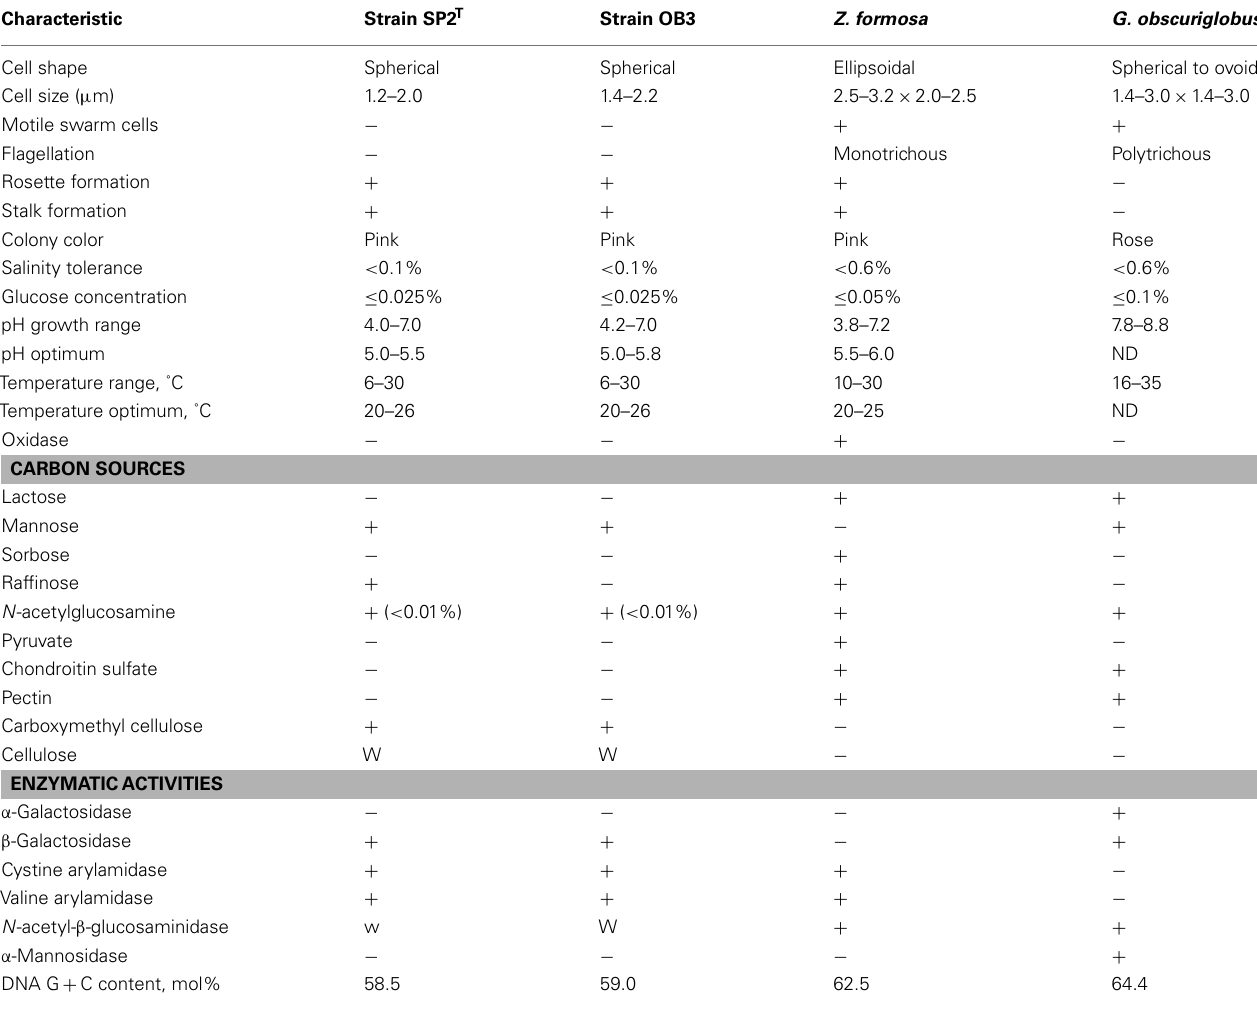
Table 1 | Phenotypic characteristics of strains SP2 T and OB3 in comparison to those of Zavarzinella formosa A10 T and Gemmata obscuriglobus DSM 5831 T